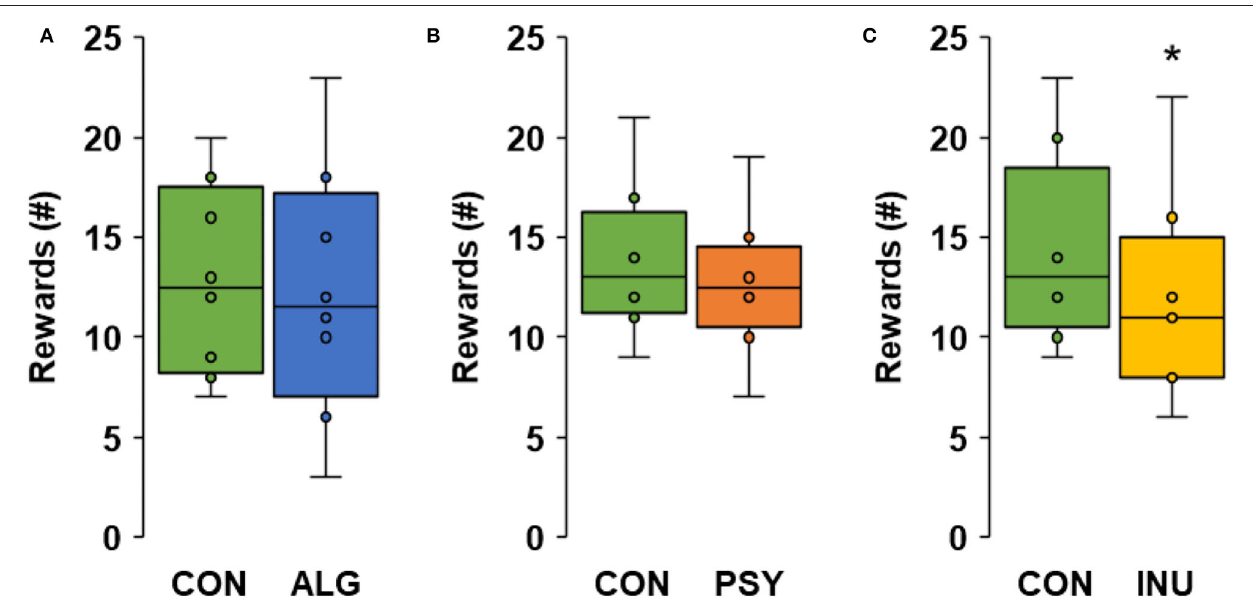
FIGURE 4 | Boxplots for the number of rewards obtained by lever pressing of cats ( n = 8) after a morning meal without (CON) or with alginate [ALG; test at 3h post meal; (A) ], psyllium [PSY; 5h; (B) ] or inulin [INU; 8h; (C) ]. Boxes show the interquartile ranges, whiskers show the minimum and maximum values, and the asterisk indicates difference from control ( P =